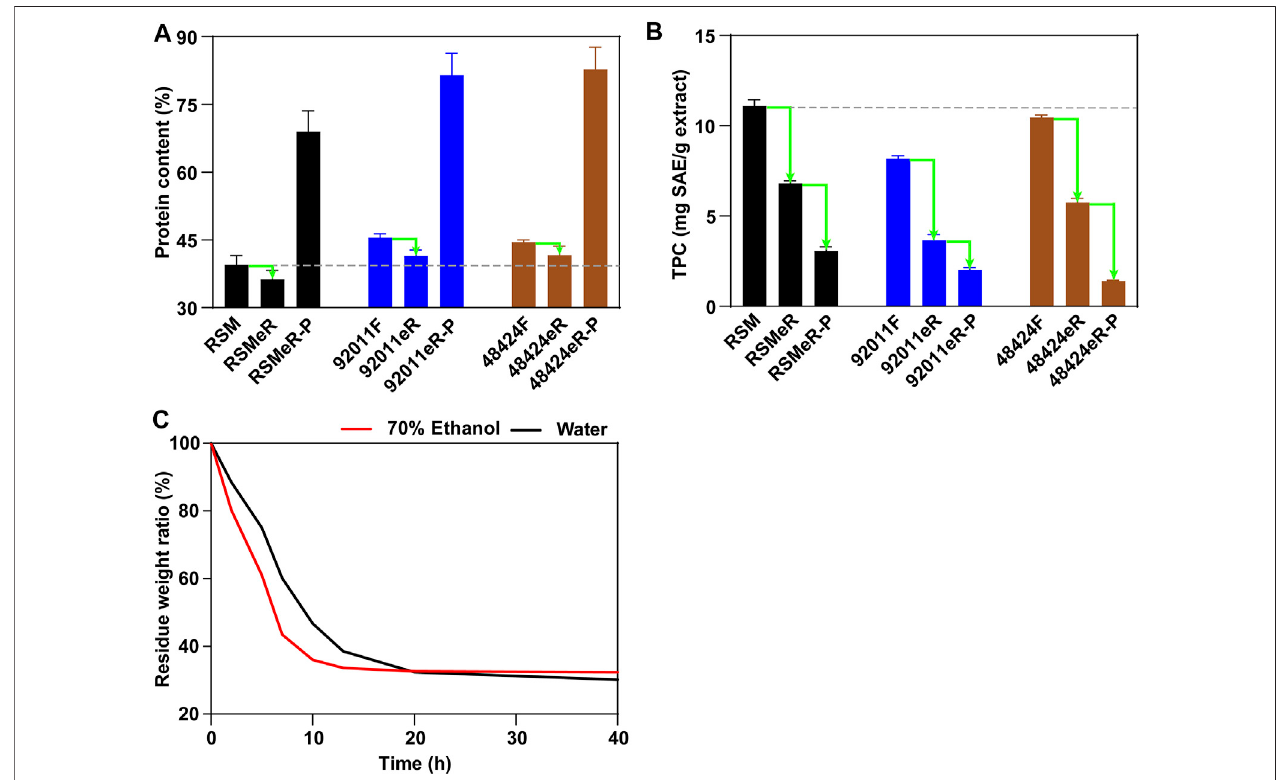
FIGURE4 | Effects oftwo-step strategy and extra protein extraction on theprotein content (A) and theTPC (B) , and the advantage ofethanol extraction fordrying residue of RSM (C) .